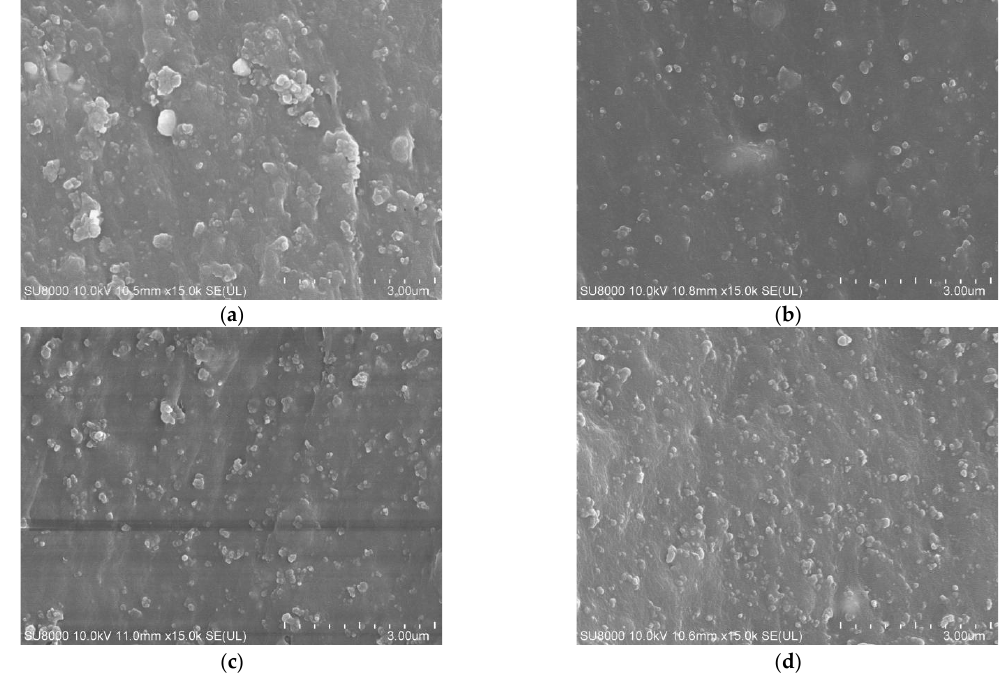
Figure 7. Scanning electron micrograph of rubber composites prepared by replacing part of carbon black with spent FCC catalyst. ( a ) 1 # ; ( b ) 5 # ; ( c ) 6 # ; ( d ) 7 # . As can be observed from Figure 7, the modified spent FCC catalyst, instead of the carbon black filler in the rubber, has a better dispersion and no more obvious agglomera- tion phenomenon. When 15 phr of the modified spent FCC catalyst was used to replace